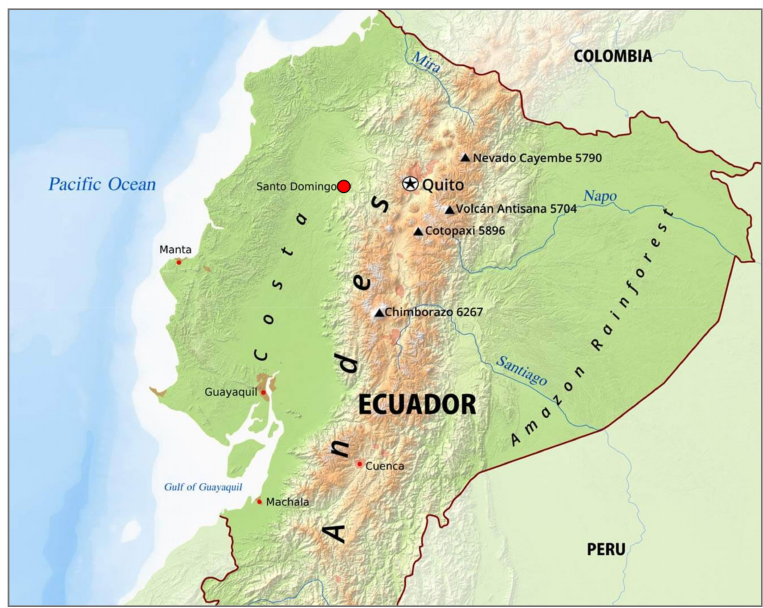
Figure 1. Map showing the reference location of samples investigated in the present study. The red dot indicates the city of Santo Domingo de los Tsachilas within the homonym